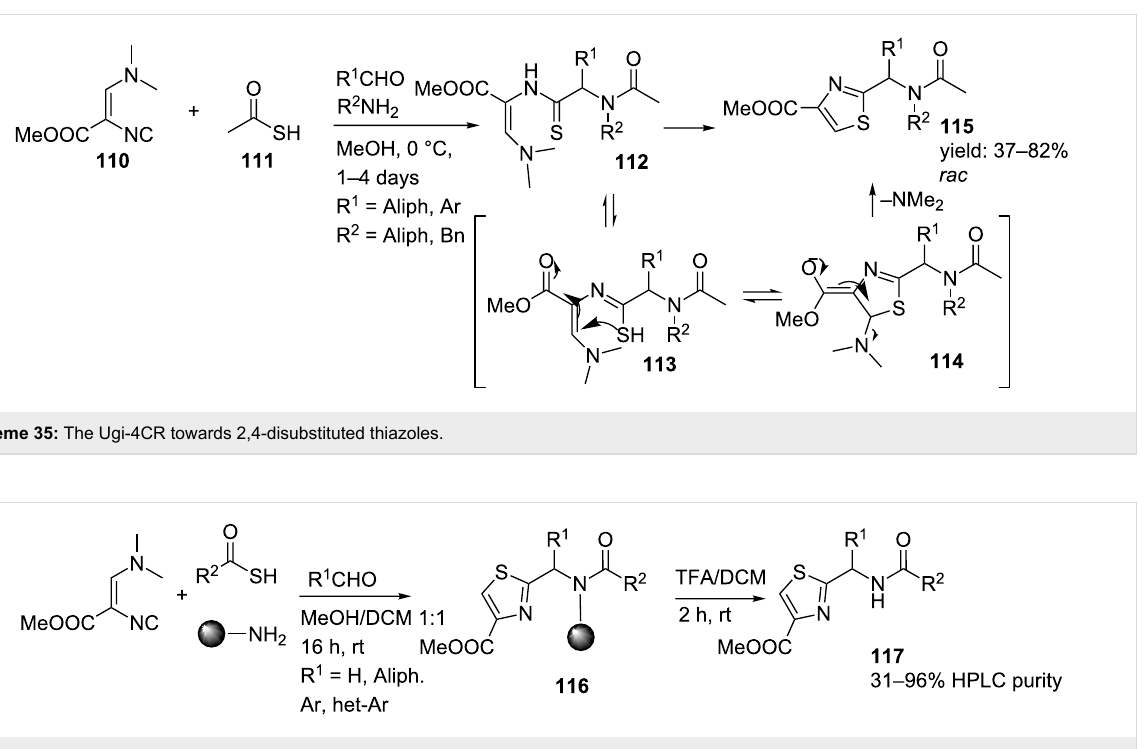
Scheme 36: Solid phase approach towards